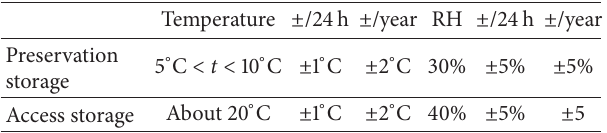
Table 3: Recommended climatic storage parameters for mechanical and for magnetic tapes.